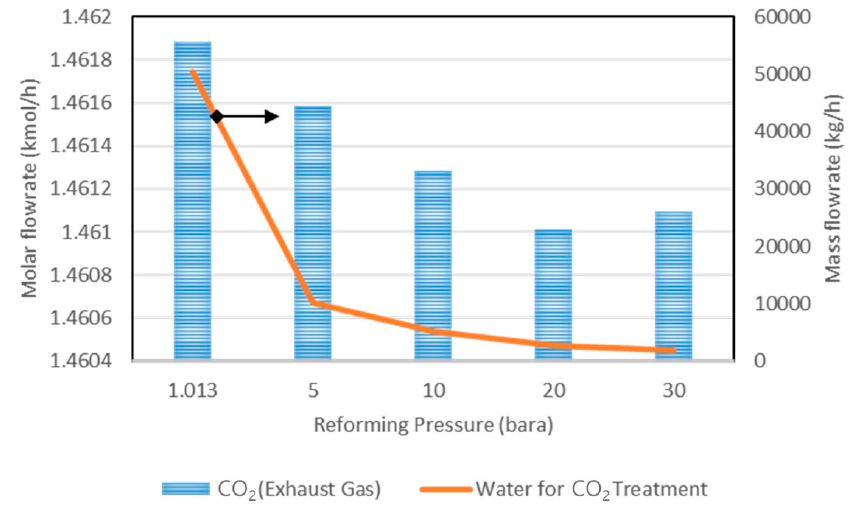
Figure 8. E ff ect of reforming pressure on CO 2 generated and water to solve CO 2. Figure 8. Effect of reforming pressure on CO 2 generated and water to solve CO 2.